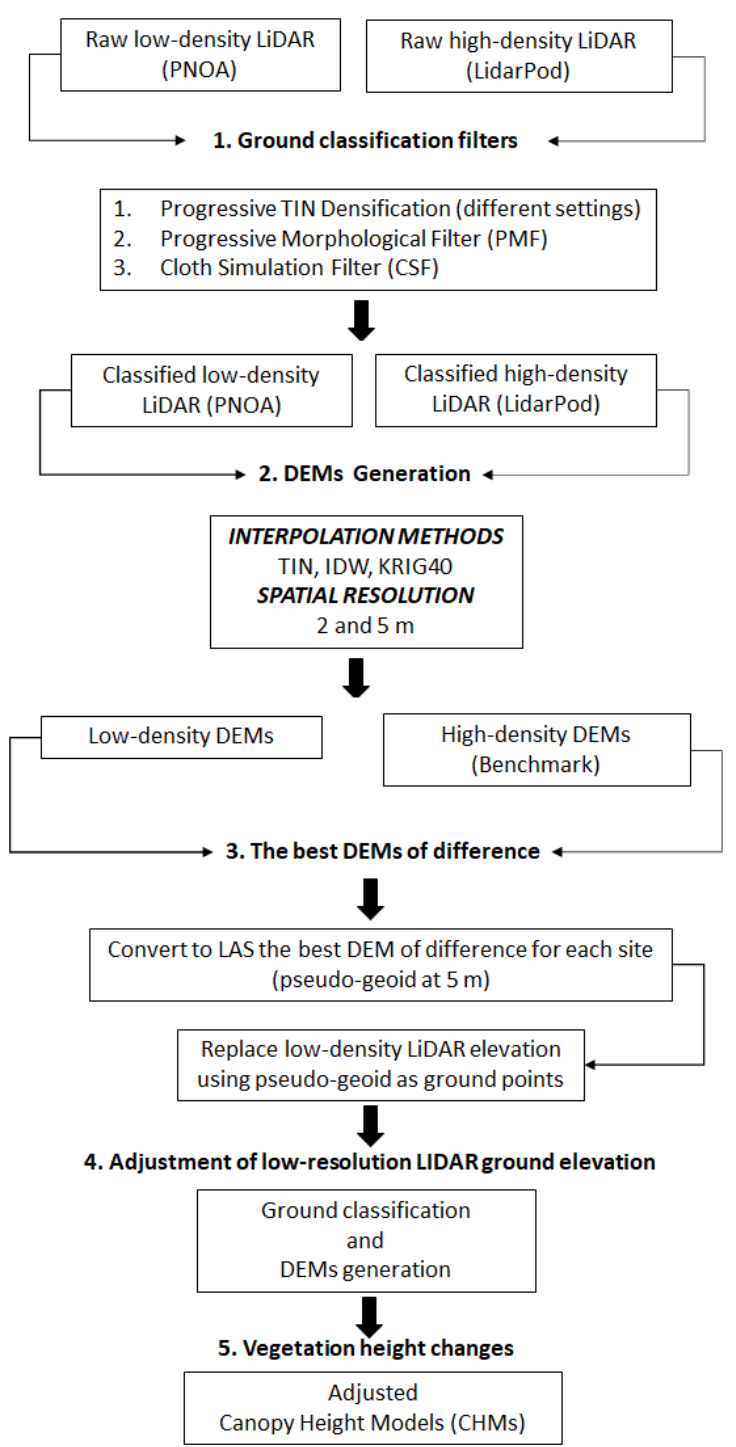
Figure 2. Flowchart of the methodology followed to adjust low-density LiDAR ground elevation to benchmark high-density LiDAR data.